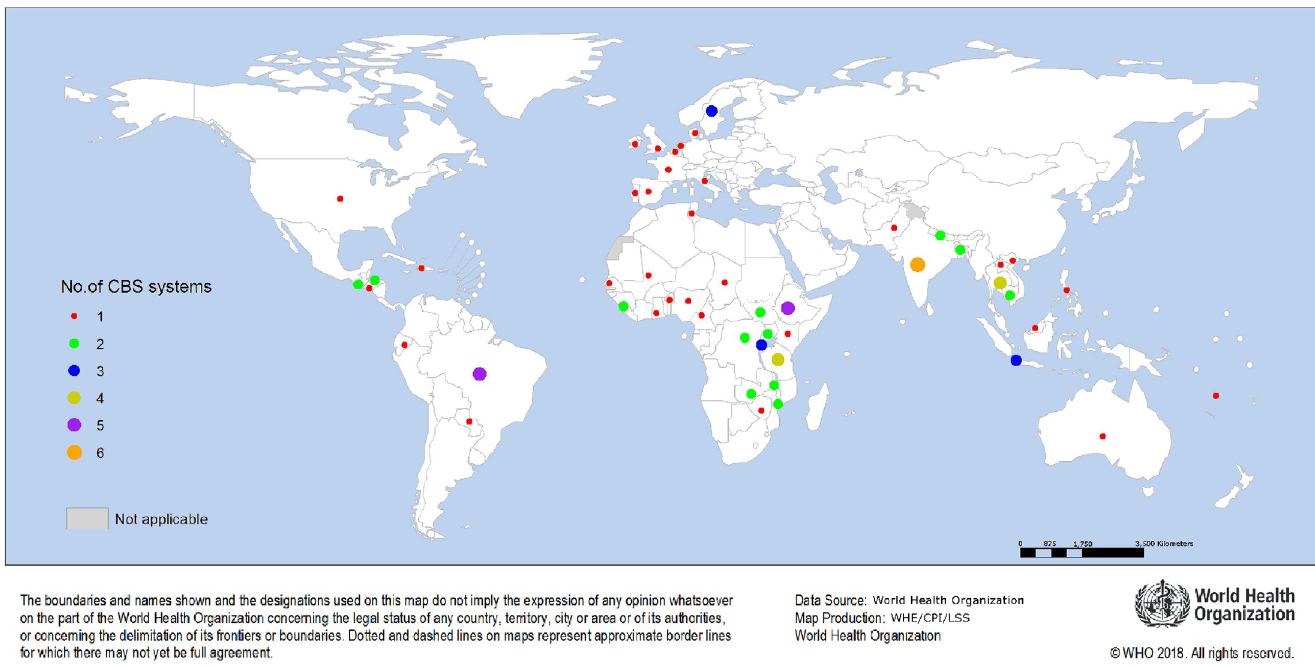
Fig 3. Distribution of CBS systems identified across different